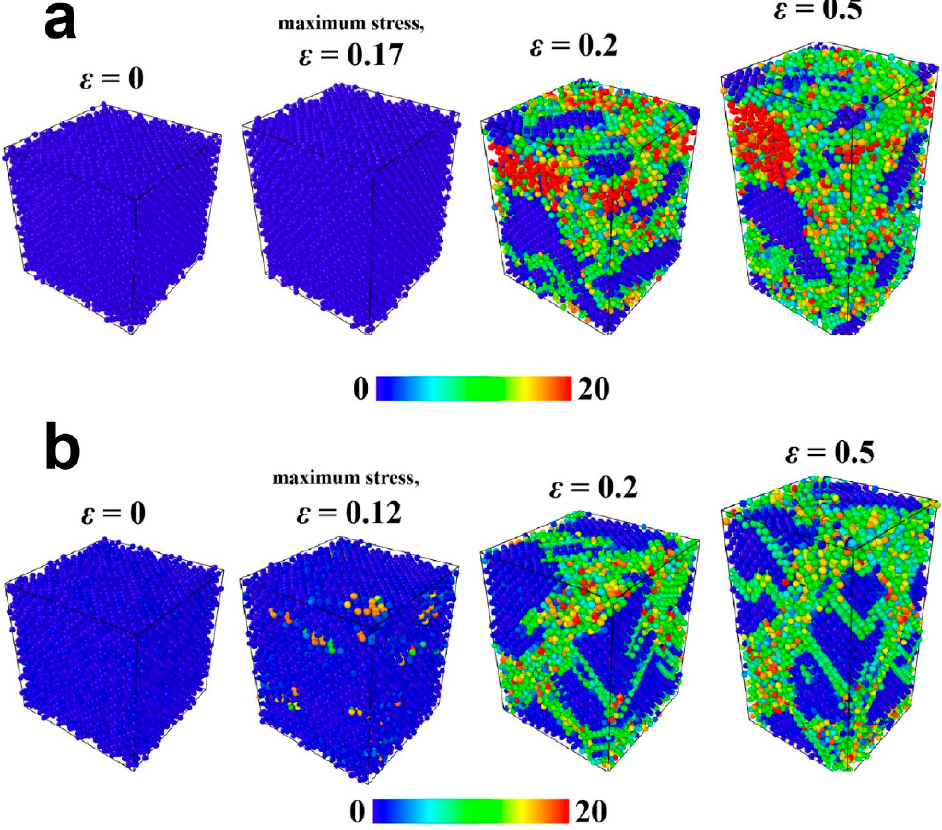
Figure 5. Atomic configuration for uniaxial tensile loading of TiAl alloy in the <001> direction at ( a ) 10 K and ( b ) 300 K. The atoms are colored according to the centrosymmetry parameter values calculated for the fcc crystal structure.